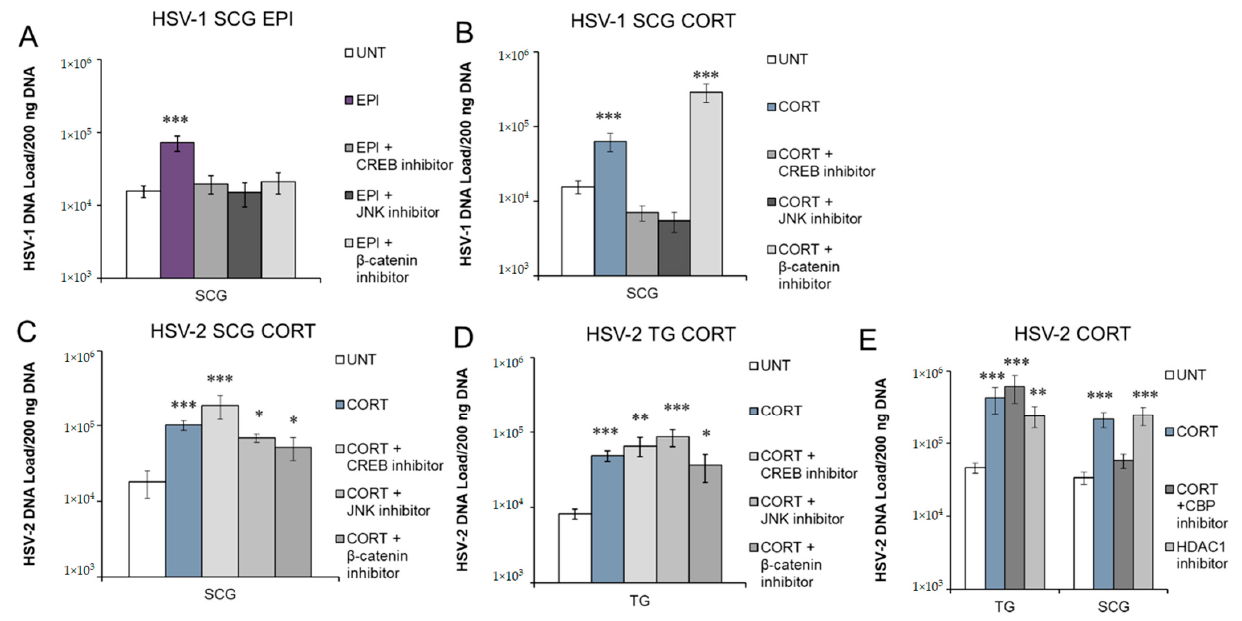
Figure 6. Inhibition of transcription factors and protein kinases differentially affect EPI- and CORT- induced reactivation. Primary adult neuronal cultures from sympathetic SCG or sensory TG were infected with HSV-1 or HSV-2 in the presence of acyclovir for 7 days to establish latency, prior to treatment with EPI or CORT and inhibitors. HSV-1 in SCG neuronal cultures treated with EPI ( A ) or CORT ( B ), either alone or with inhibitors for CREB (666-15), JNK (SP600125), or β -catenin (iCRT14). HSV-2 in SCG ( C ) or TG ( D ) cultures treated with CORT either alone or with CREB, JNK, or β -catenin inhibitors. ( E ) HSV-2 in SCG and TG cultures treated with CORT, CORT with p300/CBP inhibitor C646, or HDAC1 inhibitor pyroxamide alone. Viral DNA was quantified in A–E by viral DNA collected 72 h posttreatment, measured by qPCR. Data are means ± SEM, n > 3; * p < 0.05; ** p < 0.01; *** p < 0.001.